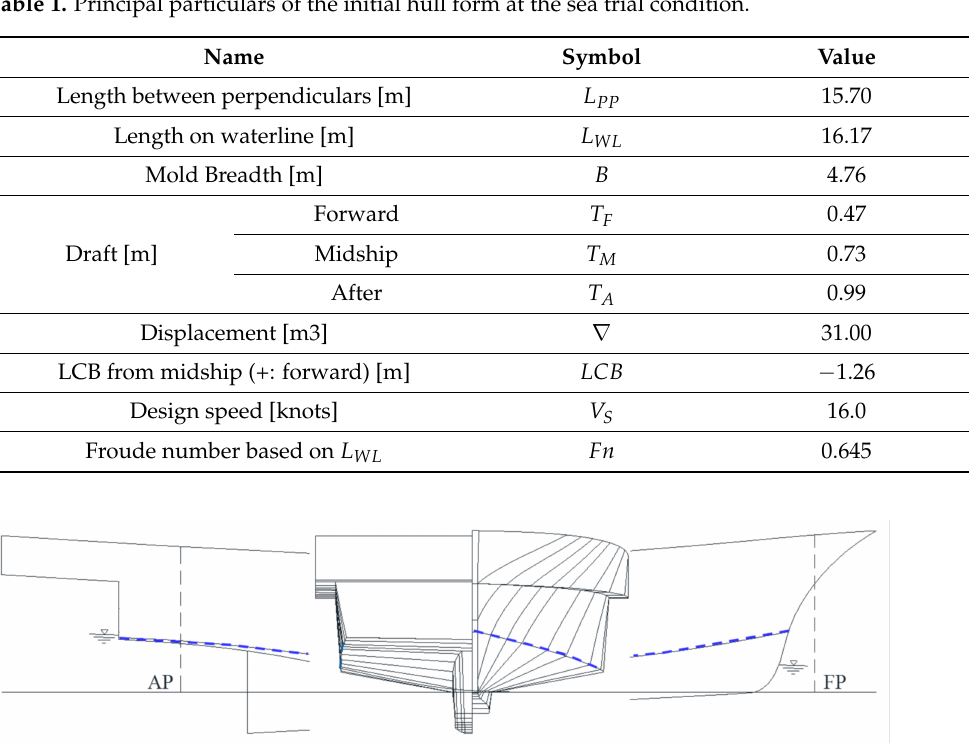
Table 1. Principal particulars of the initial hull form at the sea trial condition.